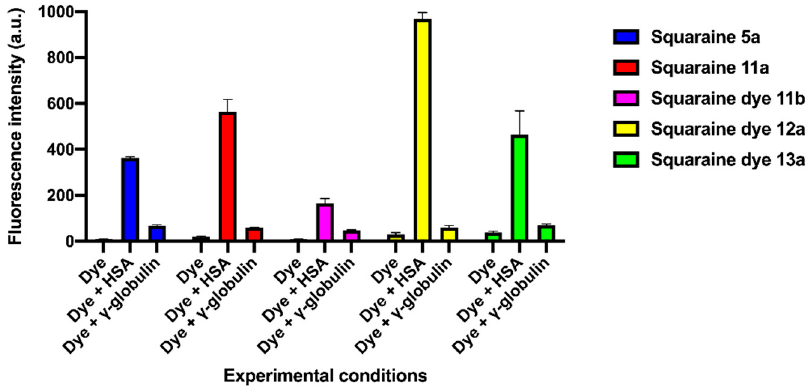
Figure 3. Graph for comparison of the fluorescence intensity maximum to the maximum emission wavelength of squaraine dyes 5a , 11a , b , 12a , and 13a in phosphate buffer pH 7.4 at a concentration of 2.0 µM in the presence and absence of human γ -globulin and serum albumin proteins at a concentration of 3.0 µM. Fluorescence intensities were obtained at the incubation time with the highest albumin–dye interaction and are presented as arbitrary units (a.u.).